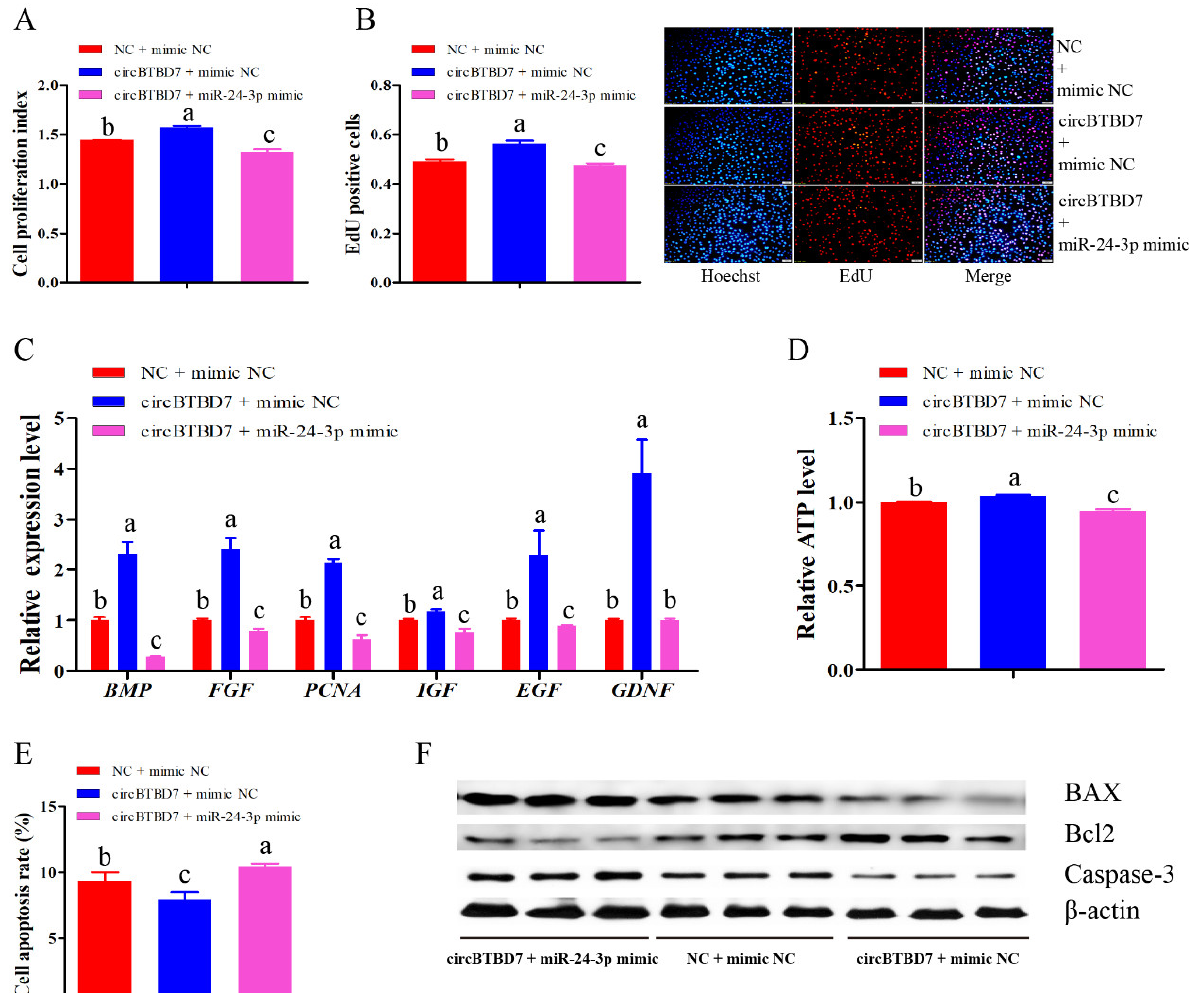
Figure 5. miR-24-3p attenuates the effects of circBTBD7 in immature porcine Sertoli cells. Three co-transfection treat- ments were performed in this section, including NC + mimic NC, cirBTBD7 + mimic NC, circBTBD7 + miR-24-3p mimic. The cell proliferation of each co-transfection group was measured using CCK-8 ( A ) and EdU ( B ) incorporation assays ( n = 3). The representative images of EdU incorporation assay are listed. Scale bar = 200 µ m. ( C ) The mRNA expression of cell proliferation marker genes was checked using the qRT-PCR assay ( n = 3). The pig-TBP gene was used as the internal control. ( D ) The relative ATP level was measured in each co-transfection group ( n = 3). ( E ) The cell apoptosis rate was detected and counted using the Annexin V-FITC/PI staining assay ( n = 3). ( F ) Western blot assay was used to detect the protein expression of cell survival-related genes in each co-transfection group ( n = 3). Data are presented as the mean ± S.D. Different letters mean values within each section were significantly different.